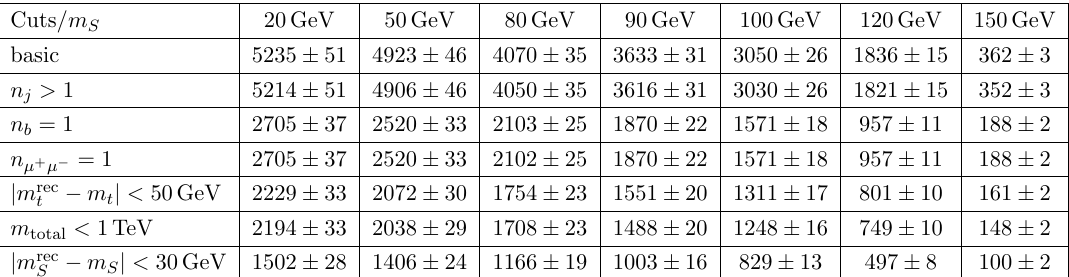
Table 2 . Event yields after each cut for the seven benchmark signal points, in the analysis for presented assume a collected luminosity of L = 150 fb (cid:0) 1 .